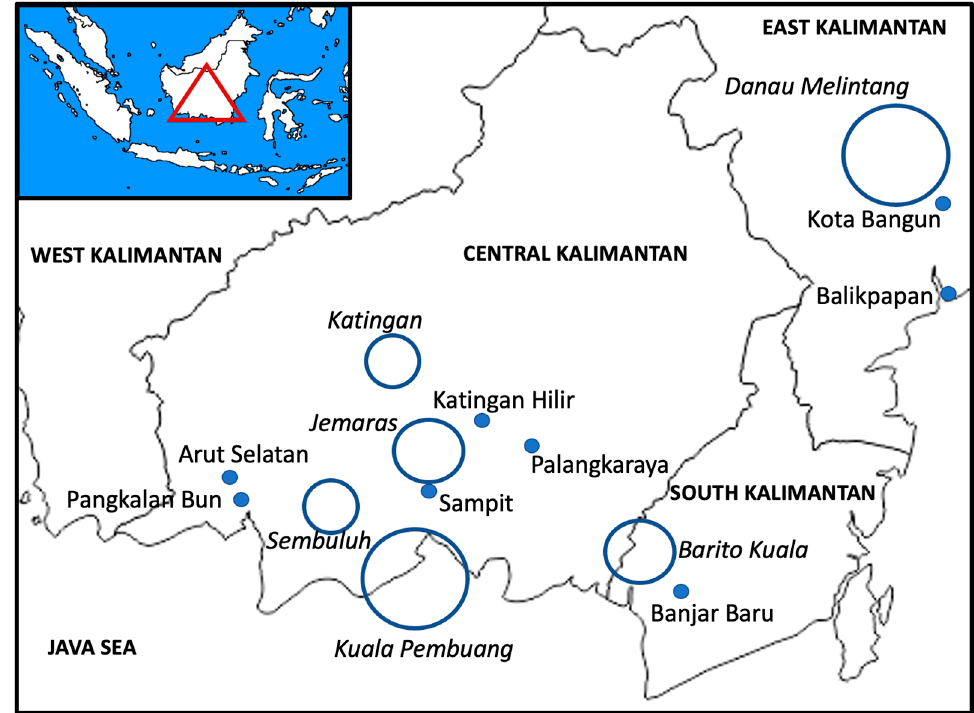
Figure 1. Trade in Southeast Asian box turtles Cuora amboinensis in Indonesian Borneo, with locations mentioned in the text. Blue dots with plain lettering depict towns or cities where traders and exporters are based, circles (roughly proportional to the number of turtles being harvested) represent source areas, with names in Italic, names of provinces are in bold. The insert shows the location of Central Kalimantan within Indonesia.